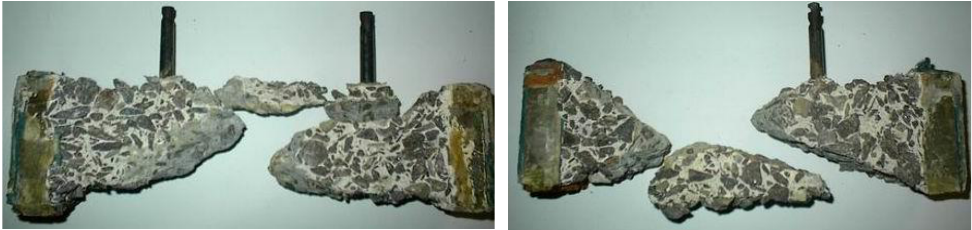
Figure 14. The character of the typical destruction of prism samples due to the corrosion of concrete.